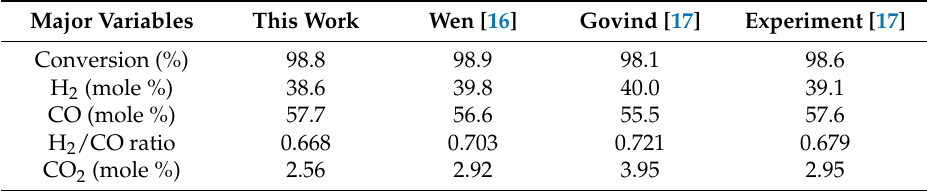
Table 7. Simulation results and comparison of previous models with experimental data (Dry